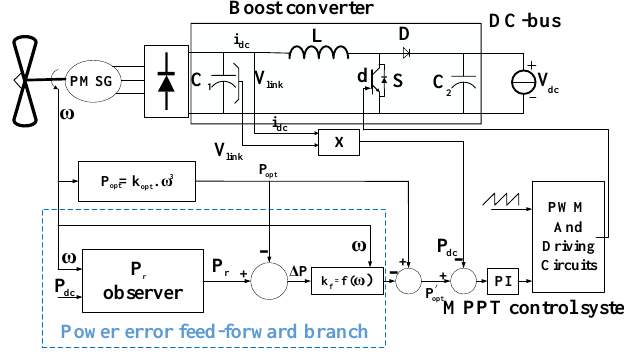
Figure 15. Control scheme for direct-drive PMSG-based wind turbine with adaptive-speed. Energies 2018 , 11 , x FOR PEER REVIEW